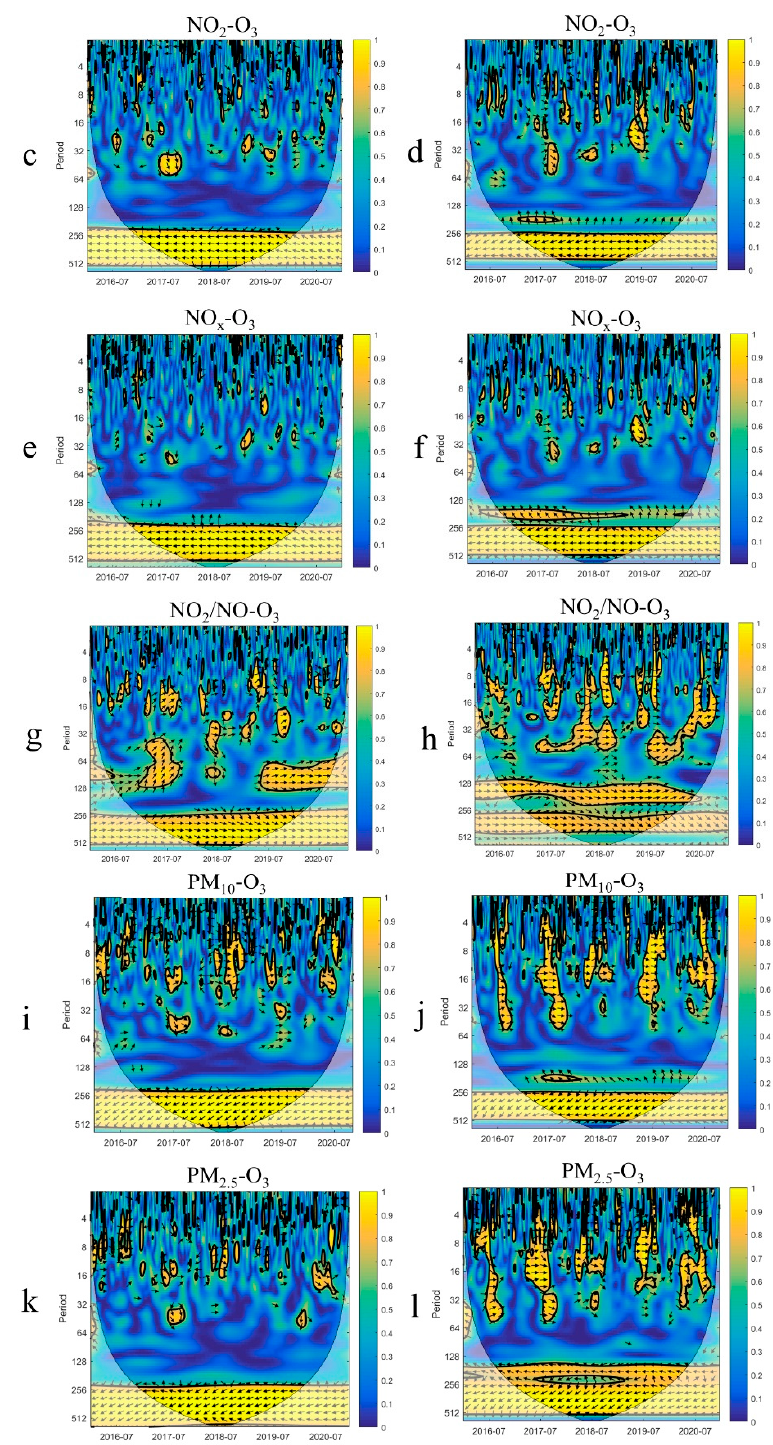
Figure 8. Wavelet coherence between O 3 and meteorological factors. The unit of the period is days. The thick contour enclosed regions of greater than 95% confidence for a red noise process, the cone of influence where edge effects might distort the picture is shown as a lighter shade. The legend on the right shows the intensity of the wavelet power. The relative phase relationship is shown as arrows (with in-phase pointing right, anti-phase pointing left, and O 3 leading factors by 90 ◦ pointing straight down)